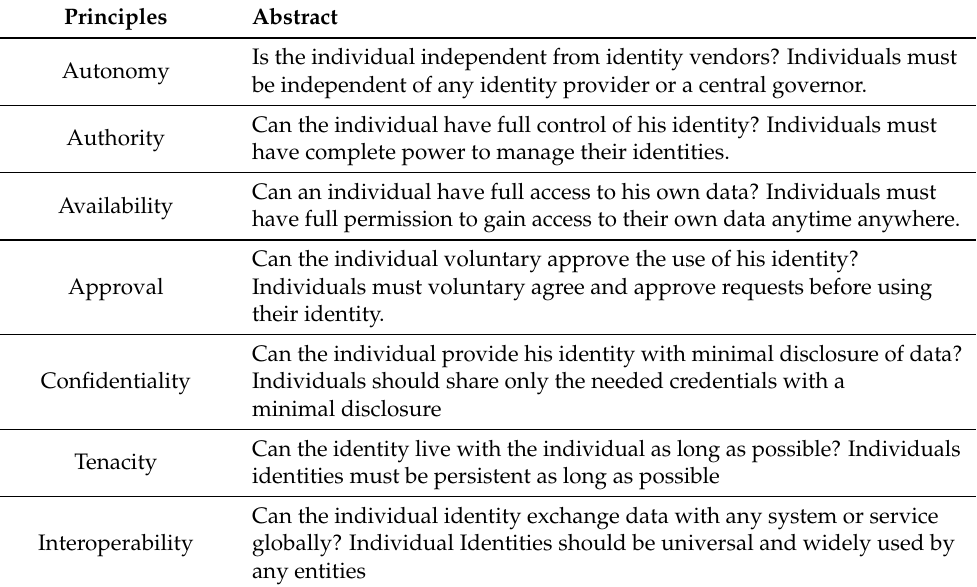
Table 1. The seven criteria of identity management.